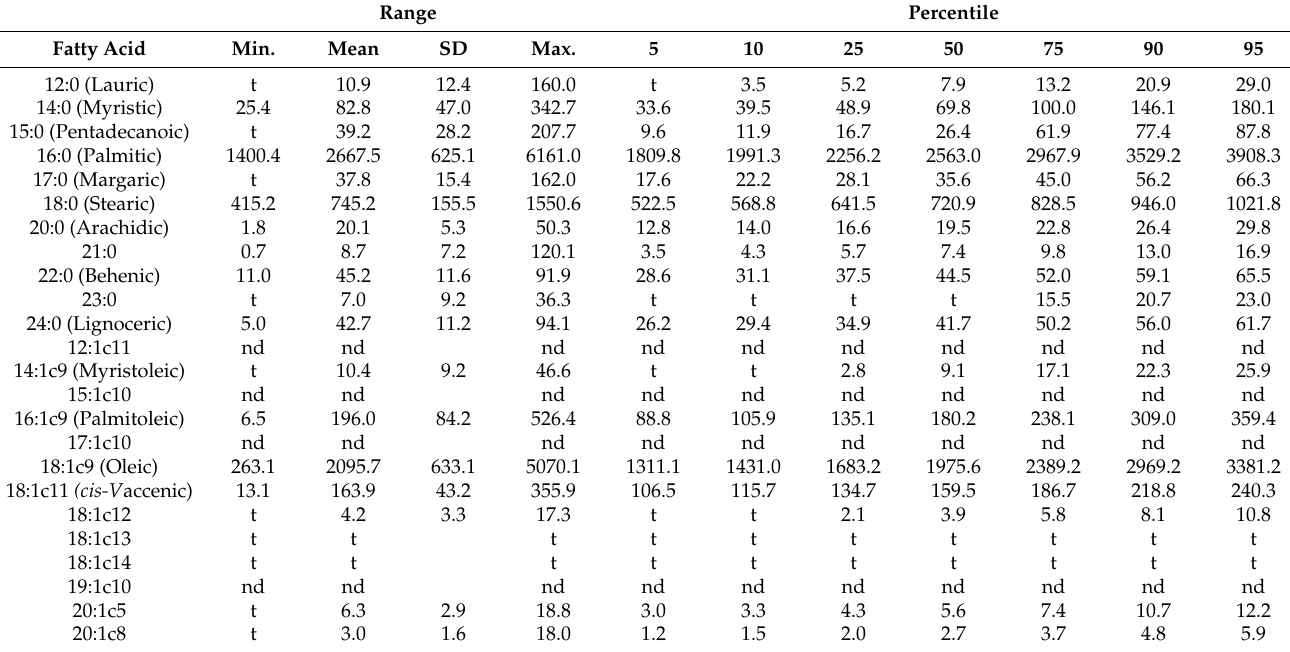
Table 2. Range, mean, and percentiles of fatty acid concentrations ( µ mol/L) of serum total